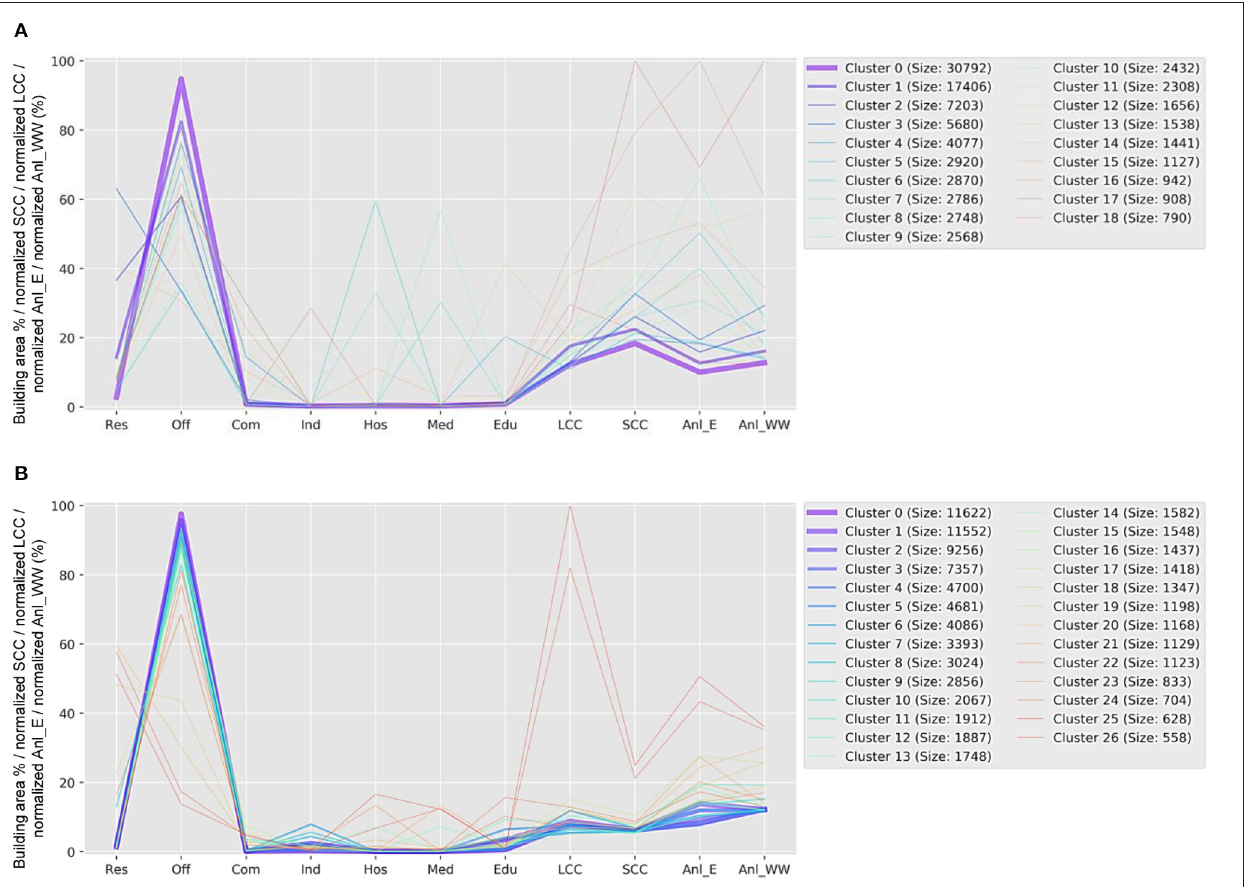
FIGURE 6 | Traces of the cluster features—i.e., building area percentages for Residential, Office, Commercial, Industrial, Hospitality, Medical, and Educational buildings ( Table 1 shows the building types belonging to each of these building-uses), normalized LCC and SCC, normalized annual energy (Anl_E), and wastewater treatment demand (Anl_WW)—across the centroids of the clustered neighborhoods for (A) scenario 1 and (B) scenario 2. Each centroid is shown as a unicolor line connecting eleven points across the seven building-uses and the four metrics.